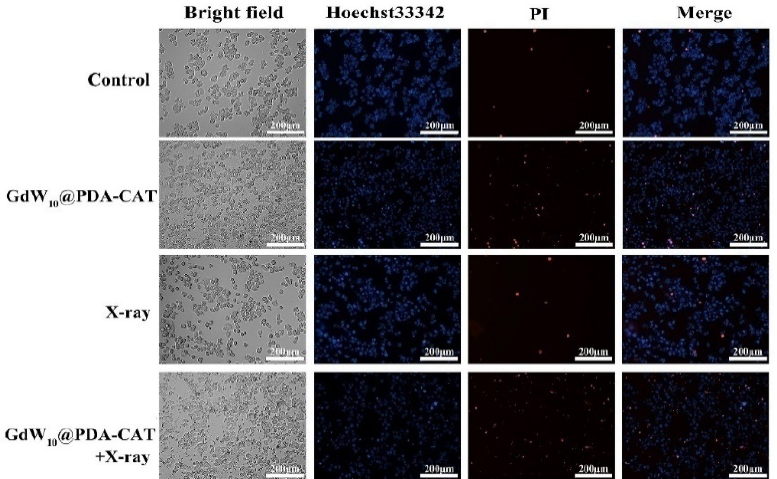
Figure 3. HT29 cells treated with GdW10@PDA-CAT (50 µ g/mL) for 24 h and then stained with Hoechst33342 and PI to detect the Living/dead cells. Scale bar: 200 µ m.